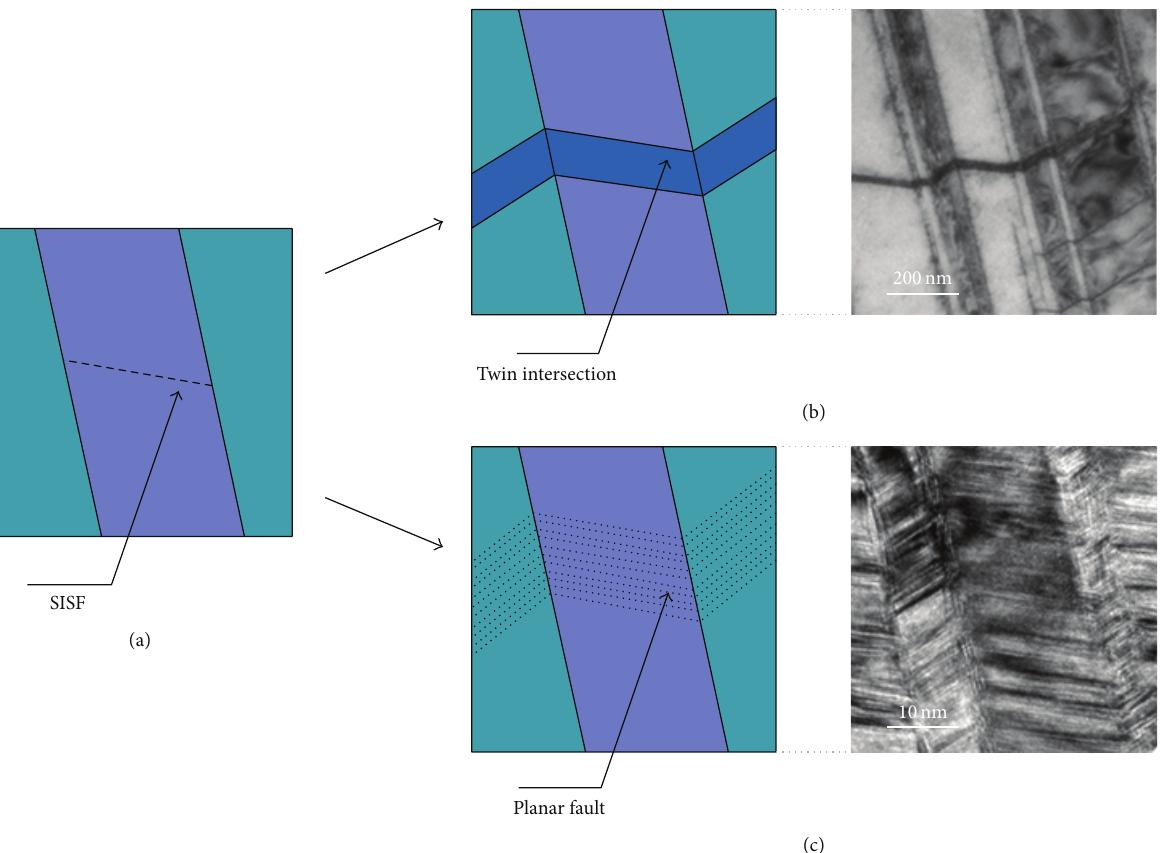
Figure 5: (a) A schematic illustration of a SISF formed inside a 𝛾 lath. (b) A schematic illustration and a TEM graph of the twin intersection. (c) A schematic illustration and a HRTEM graph of a high concentration of planar